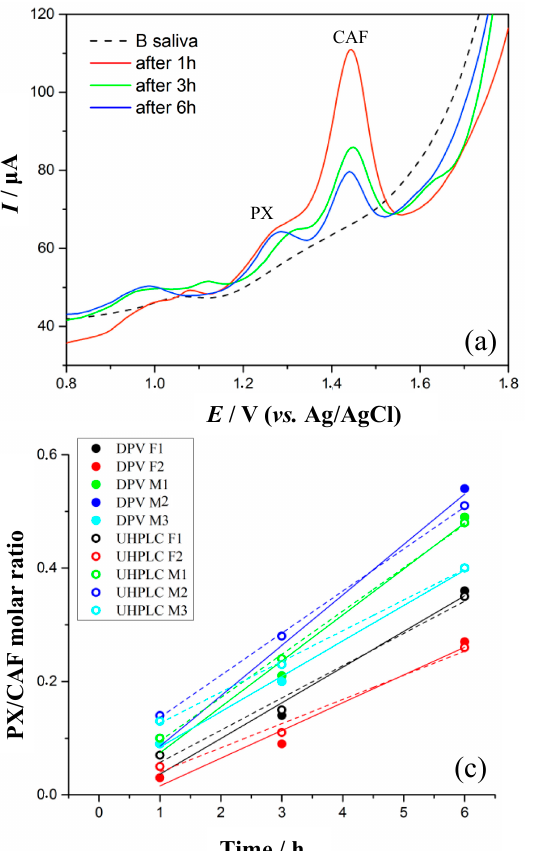
Figure 6. ( a ) DP voltammograms containing paraxanthine (PX, E PX = +1.24 V) and caffeine (CAF, E CA F = +1.44 V), isolated from saliva, in 0.1 M H 2 SO 4 on the GC electrode, with a scan rate of 5 mV s − 1 : predose as blank saliva (B saliva), 1, 3 and 6 h upon administration of a single 200 mg CAF dose from a male volunteer; ( b ) CAF and PX concentration-time profiles by DPV and UHPLC for a male volunteer in three different days upon administration of a single 200 mg CAF dose with SD of the three measurements as error bars; ( c ) PX/CAF molar ratios vs. time (h) by DPV (filled circles and solid lines) and UHPLC-UV (empty circles and dashed lines) for all five subjects (F1 and F2 for females and M1, M2 and M3 for males); ( d ) Correlation plot of PX/CAF molar ratios obtained by DPV vs. UHPLC.